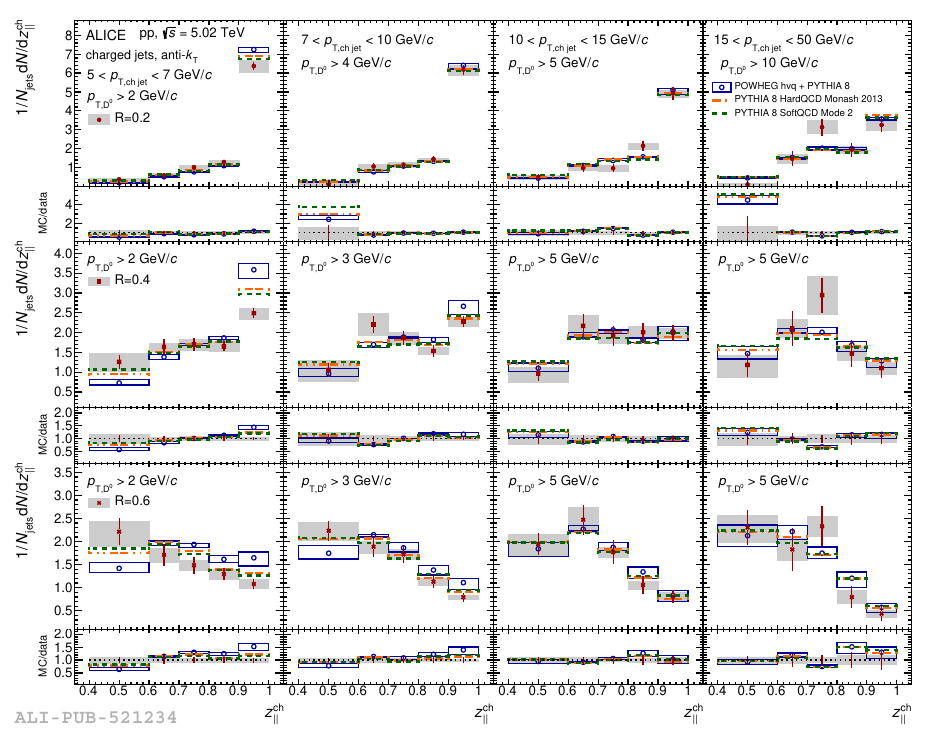
Figure 1. D 0 -jet momentum fraction distribution measured in pp collisions at √ s = 5 . 02 TeV. Vertical lines and boxes are, respectively, statistical and systematic uncertainties [4]. Jet and D 0 p T increase in panels from left to right and R increases in panels from top to bottom. Data are compared to predictions from models [3,